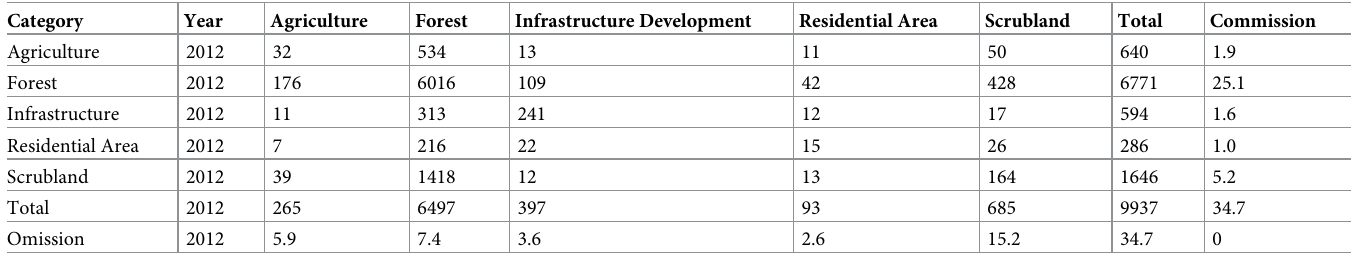
Table 2. Accuracies based on an accuracy assessment of the two LULCC maps for 2012. Rows are map categories, and columns are reference categories.